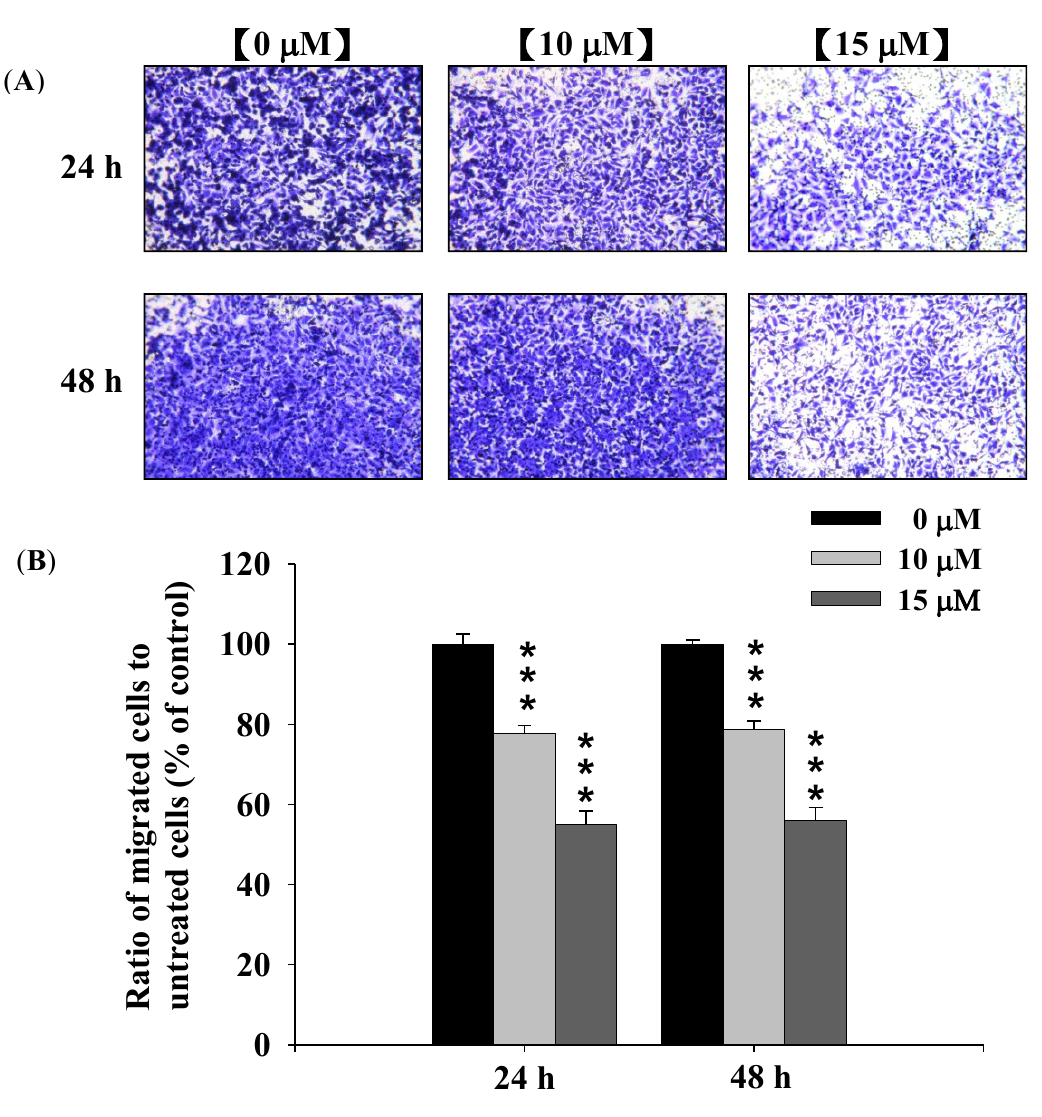
Figure 3. Deguelin suppressed the migration of U-2 OS cells in vitro . U-2 OS cells (5 × 10 4 cells/well) were incubated with 0, 10 and 15 μM of deguelin for 24 and 48 h then penetrated through to the lower surface of the filter and were stained with crystal violet and were photographed under a light microscope at 200×. Quantification of cells in the lower chambers was performed by counting cells at 200×. *** p < 0.001 significant difference between deguelin-treated groups and the untreated groups as analyzed by Student’s t test. Cells were stained with crystal violet and then were examined and photographed under a light microscope at 200× ( A ); The quantification of cells from each treatment in the lower chambers was counted at 200× ( B